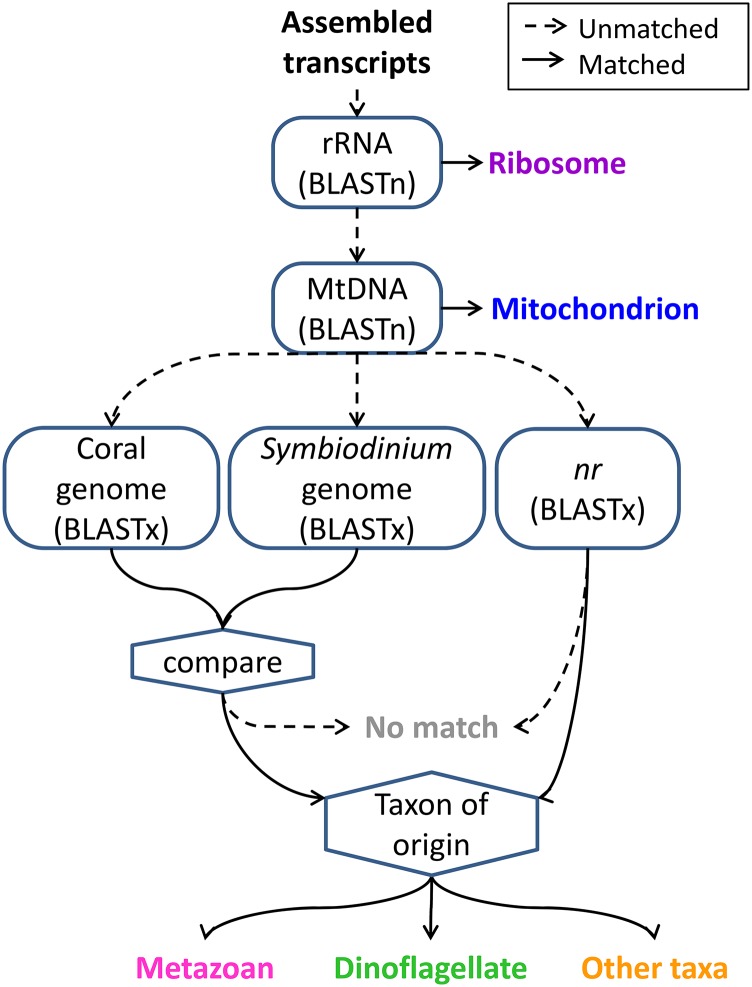
Annotation pipeline used to classify origins of each assembled transcript. A series of sequence comparisons was performed comparing each transcript against N. vectensis rRNA (SILVA: ABAV01023297, ABAV01023333), A. tenuis mitochondrial DNA (NCBI: NC_003522.1), A. digitifera and S. minutum gene models, and the NCBI nonredundant protein database (bit-score threshold of 45 for small databases; E value threshold of 10−5 for large databases). Transcripts were assigned to categories by evaluating their similarity to each database in the order shown (see Materials and Methods for details).